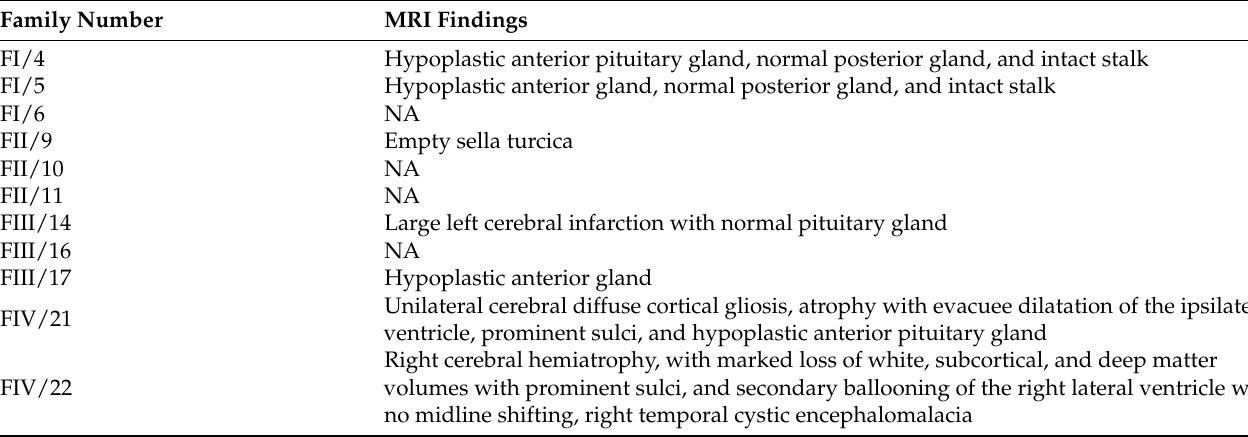
Table 3. Results of the MRI imaging: NA, not available. Family